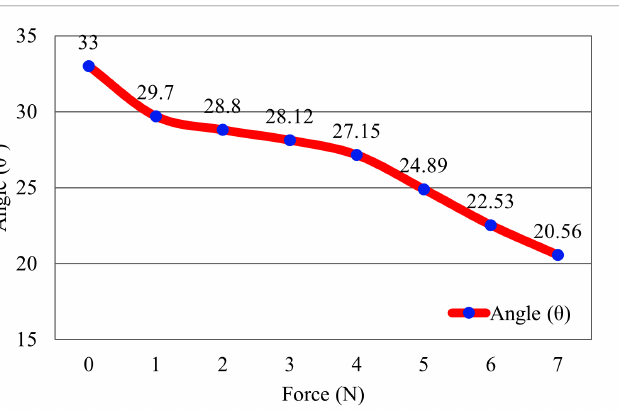
Figure 11. The co-relation between the applied force (N) and angular deviation ( θ ).